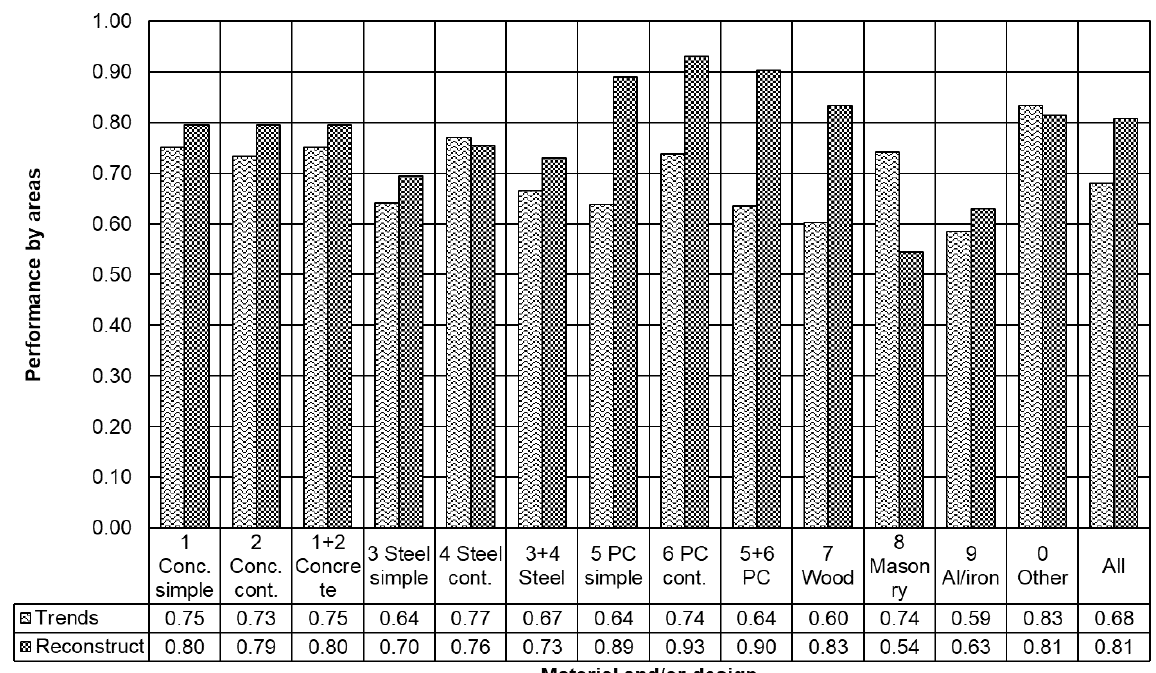
Figure 6. Comparison of deterioration trends and reconstruction performances of bridge areas.